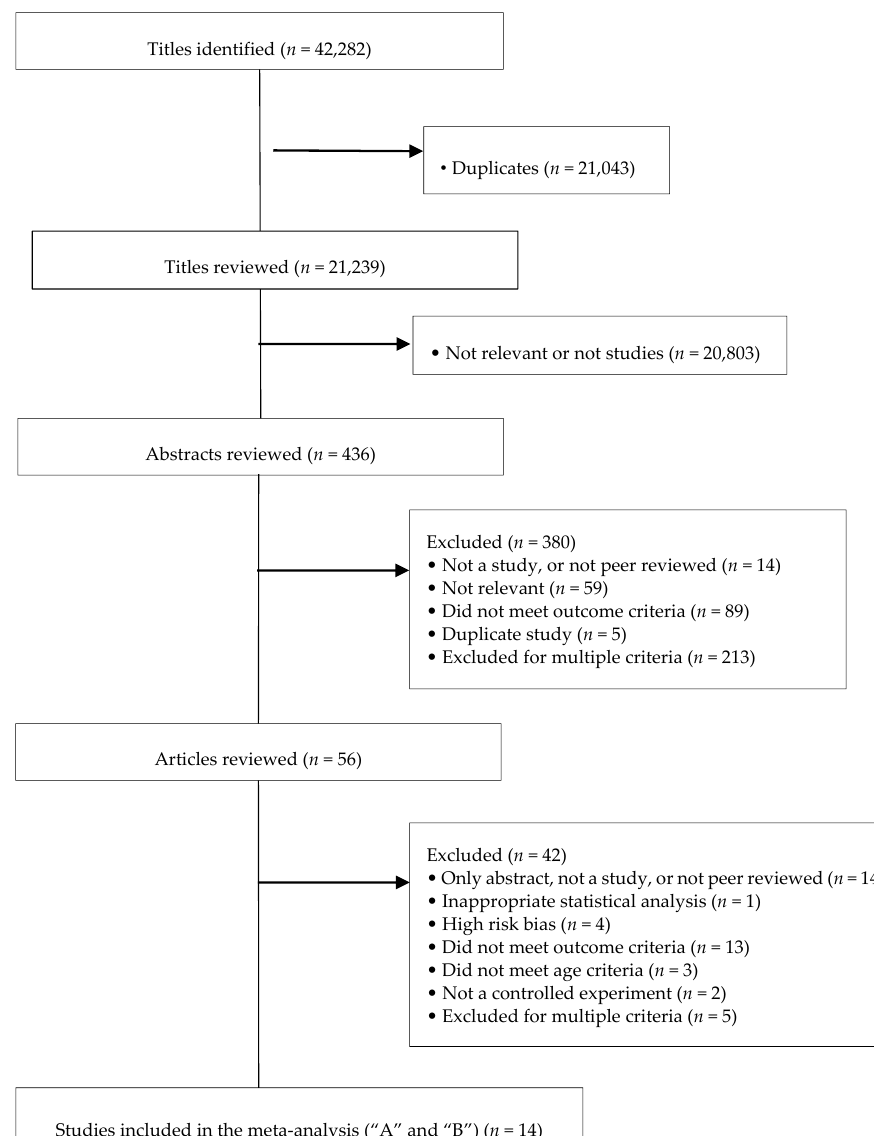
Figure 1. Flow diagram of the literature search and filtering results following the Preferred Reporting Items for Systematic Reviews and Meta-analyses (PRISMA) template.